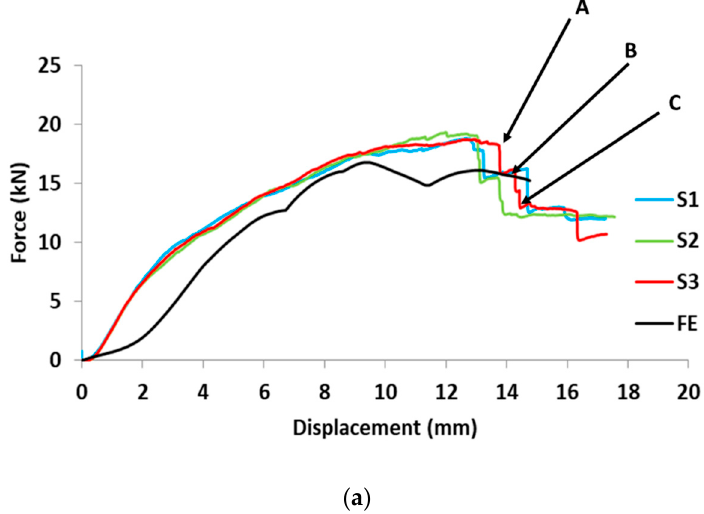
12 of 17 Figure 12. Comparison of the energy-speed curves between experimental test and numerical model. Table 3. Predicted and experimental results for composite material reinforced closed top hat . Speed (m/s)